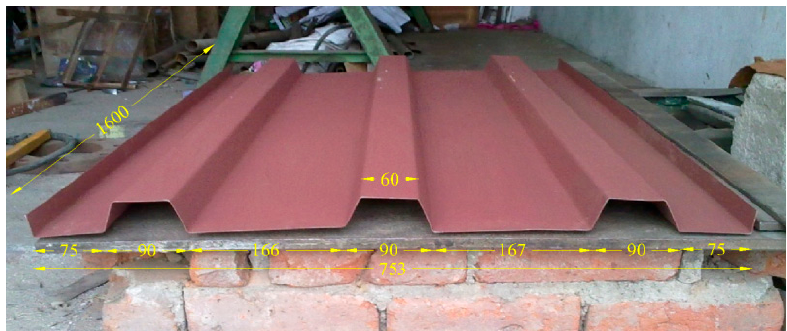
Figure 5. Trapezoidal profiled sheet (All dimensions are in mm).